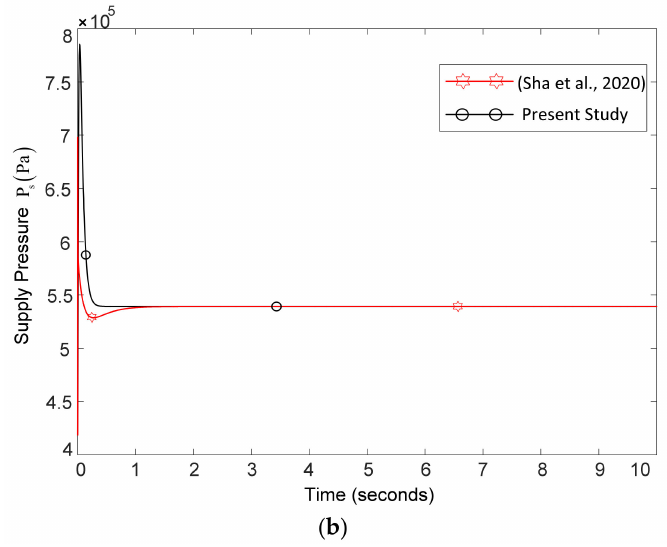
Figure 5. Control input (supply pressure) and tracking performance. ( a ) Tracking performance to attain desired fluid film thickness. ( b ) Supply pressure as a control input.